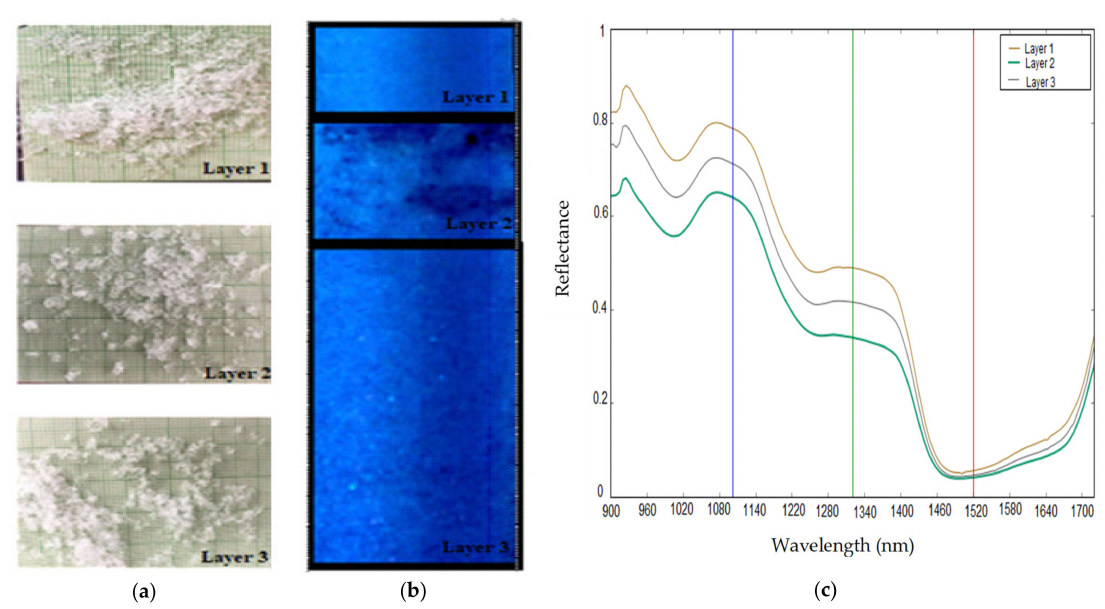
Figure 8. ( a ) Snow grains of each layer of the vertical stratigraphy; ( b ) false-color RGB image; ( c ) NIR spectral reflectance of each layer of the vertical stratigraphy (the red, green, and blue vertical lines in the spectral plot show the location of the bands used to generate the false-color RGB